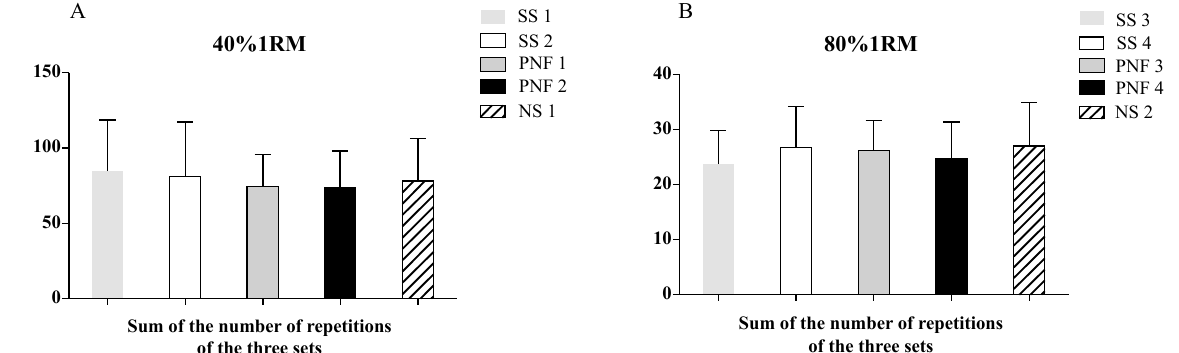
Figure 3. Comparative analysis of the number of repetitions of the three series among the